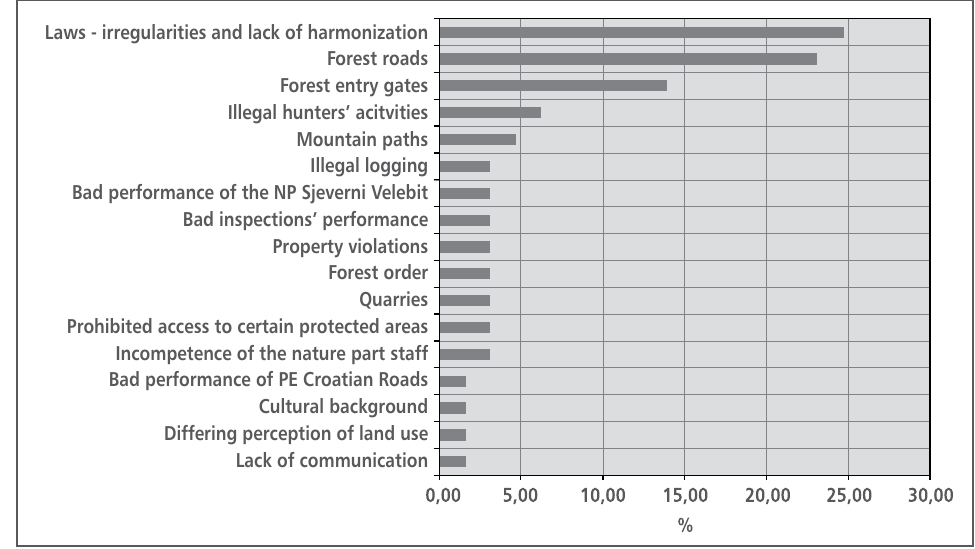
The most abundant conflicts as stated by all stakeholders Most interviewees, regardless to the coalition group they belonged to, stated that the most salient conflicts were irregularities and lack of harmonization among and within laws, then follow forest roads, forest road gates and illegal hunters’ activities